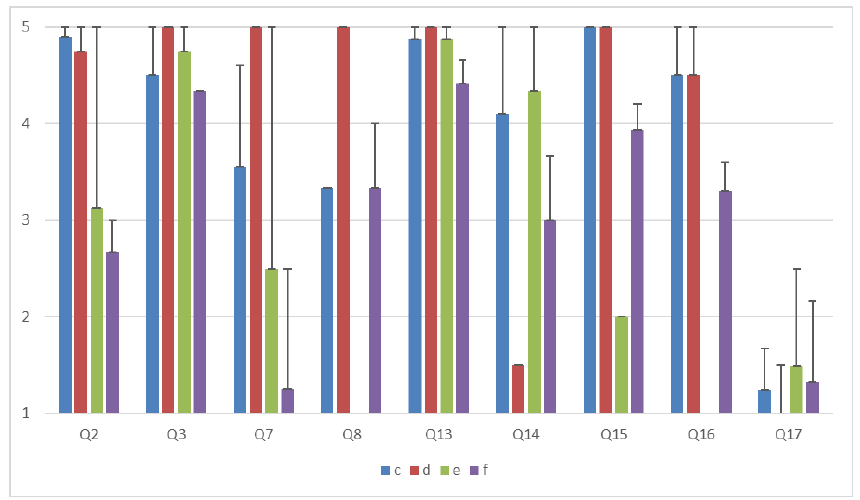
Figure 9. Subjective rating: ATC operational perception on RPAS contingency scenarios (see questions in Table 8).